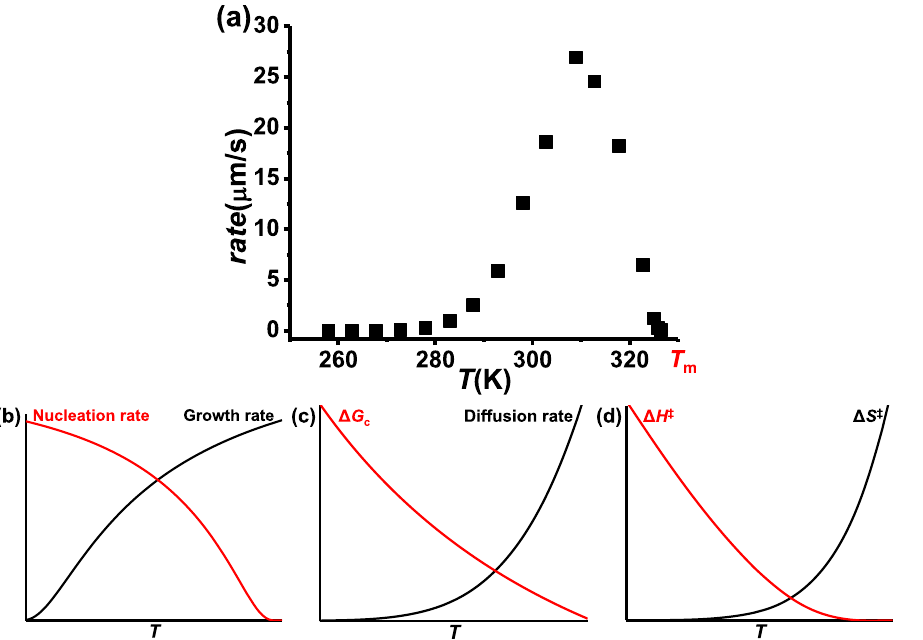
Fig. 1 Experimental results and theoretical explanations of crystal growth from congruent melts. a The rate of crystal growth of o-terphenyl; 19 ( b ), ( c ), and ( d ) are schematic representations of the parameters in CNT, ICG, and TZT that explain the rate of crystal growth, respectively. The curves in ( b – d ) are only schematic and not to